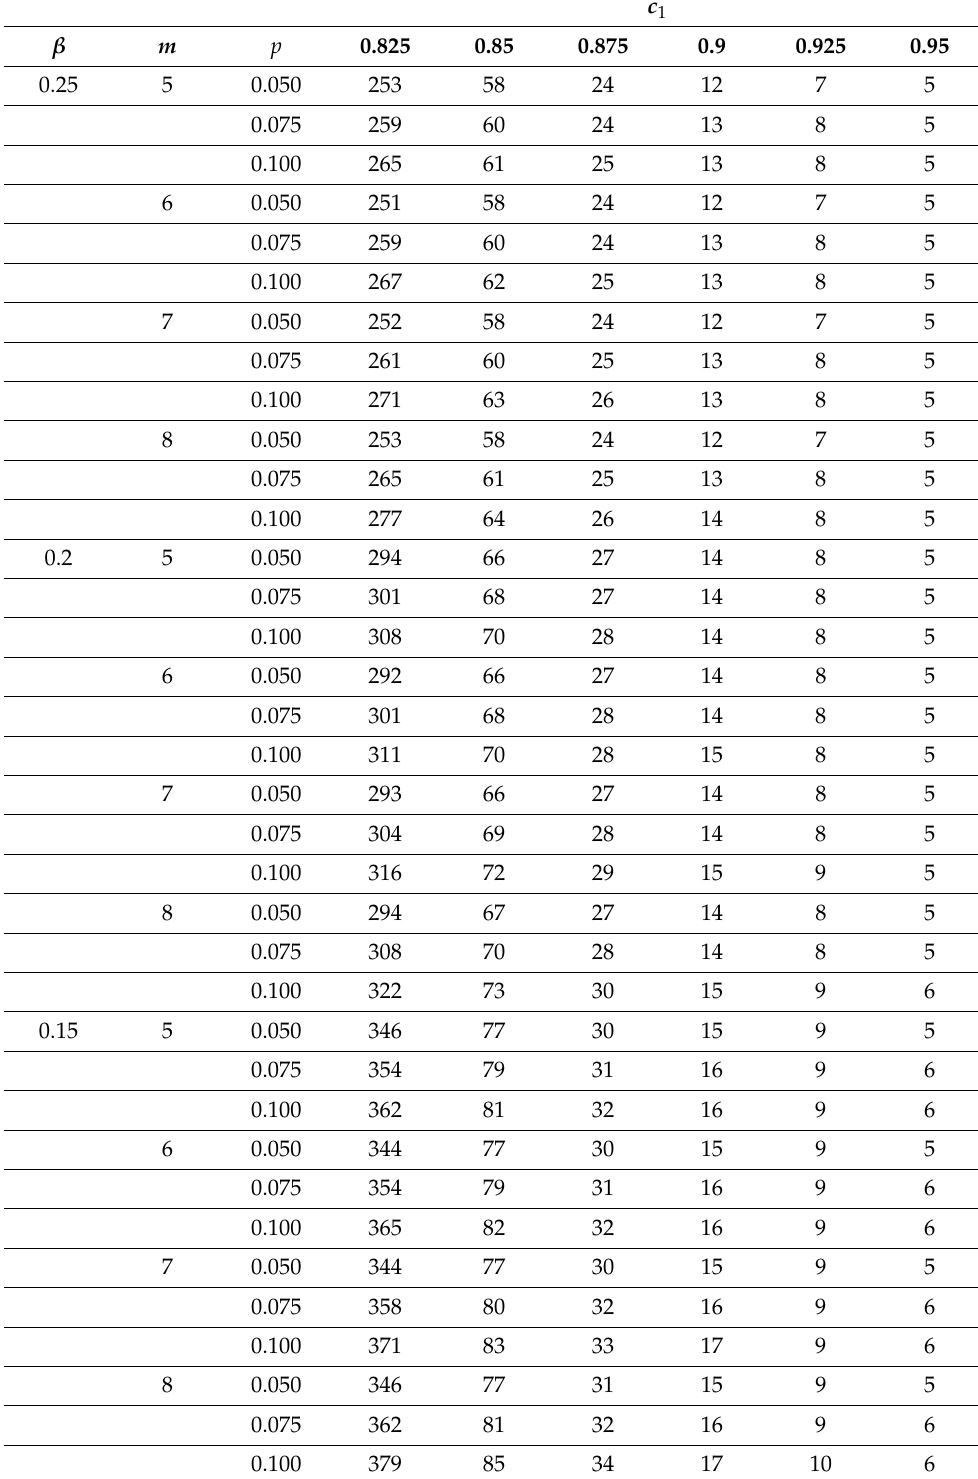
Table 3. The minimum sample size for c 1 = 0.825(0.025)0.9, m = 5(1)8 and p = 0.05(0.025)0.1 under α = 0.01, L = 0.10, T = 0.5, and c 0 =